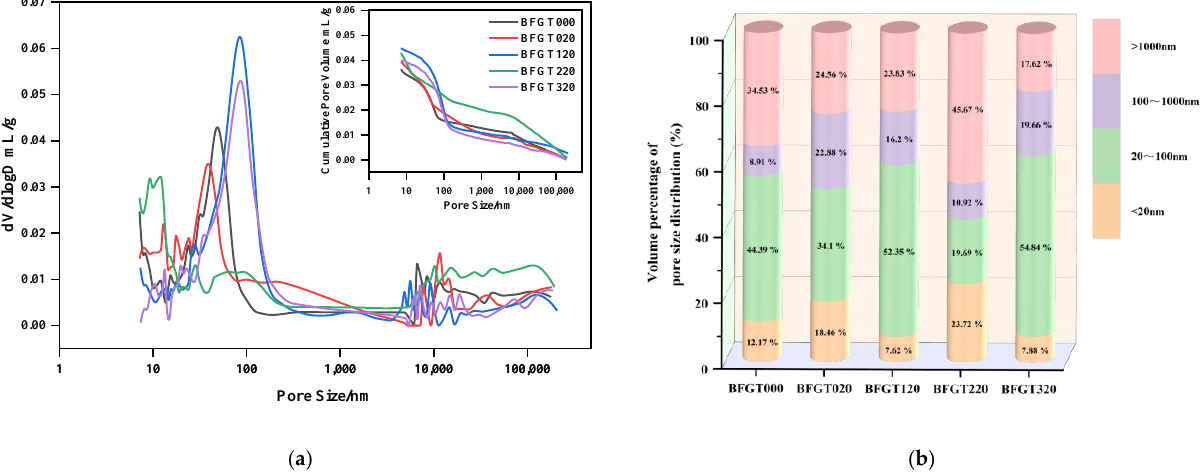
Figure 14. Pore structure distribution analysis of BFR-GTCM for 28 days: ( a ) pore size distribution; ( b ) cumulative pore volume percentage. Table 6. Porosity, total pore size and area of BFR-GTCM.